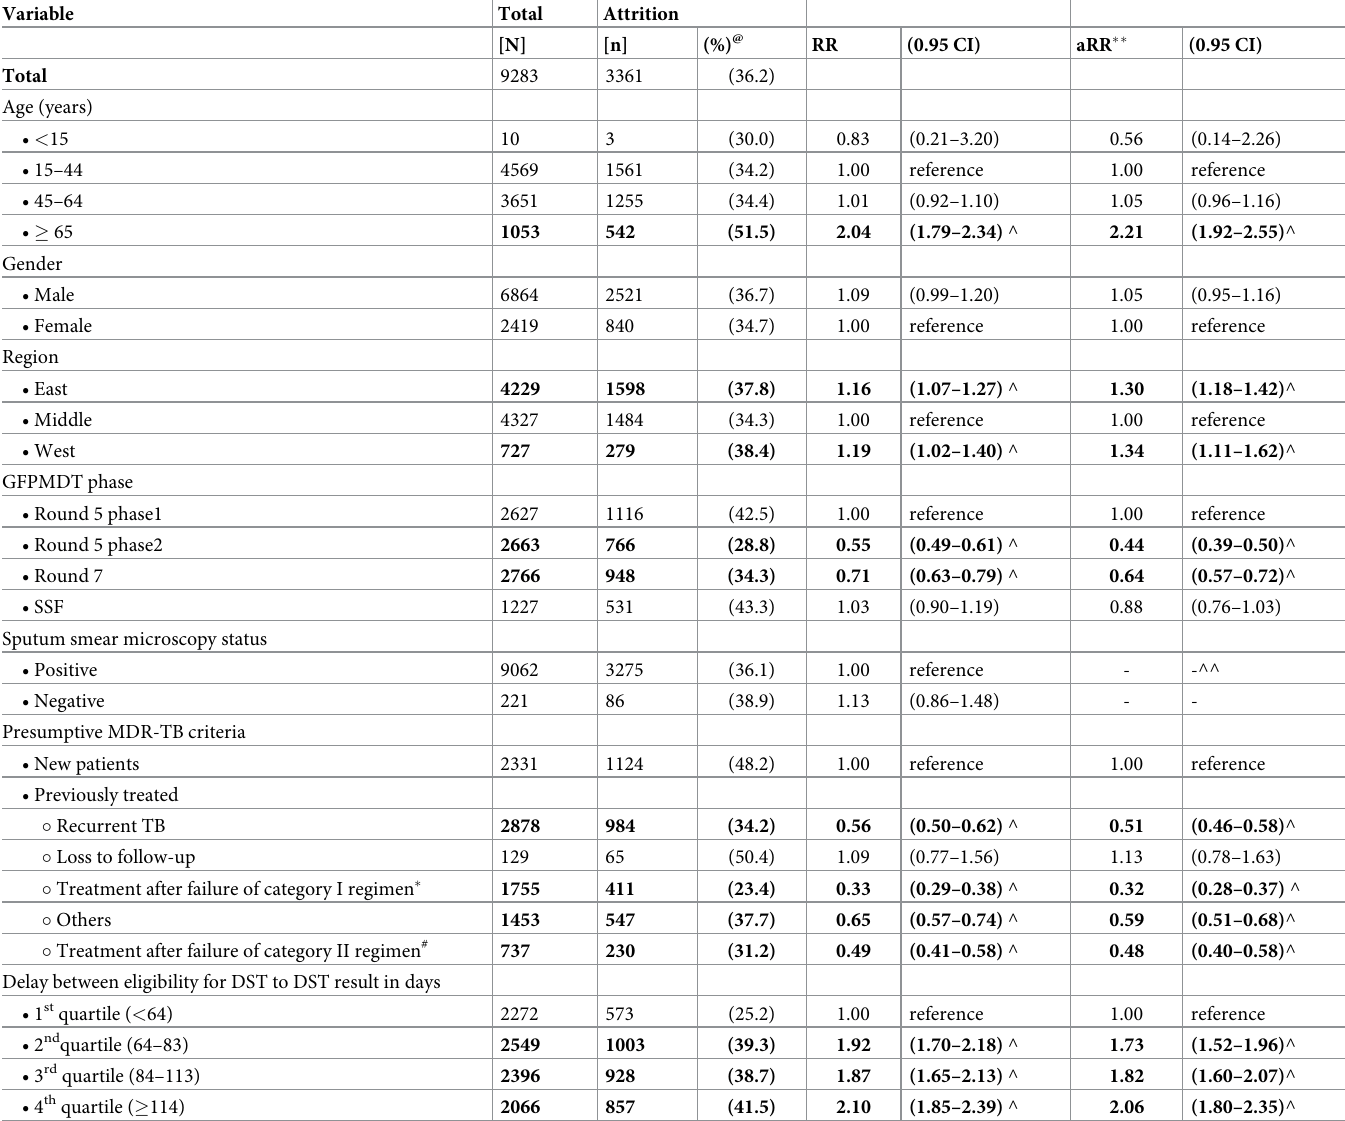
Table 4. Association of clinical and socio-demographic factors with pre-treatment attrition among patients diagnosed with MDR-TB under GFPMDT project in China, October 2006-June 2013 [N = 9283].